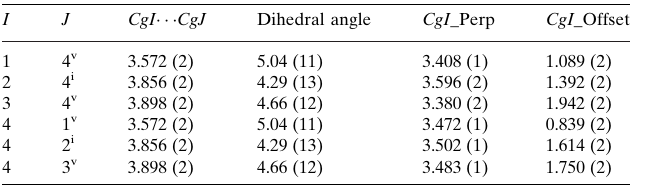
Table 3 (cid:3) – (cid:3) interactions (A˚ , (cid:4) ). Cg 1, Cg 2, Cg 3 and Cg 4 are the centroids of the C9/N10/C11–C14, C1–C4/C11/ C12, C5–C8/C13/C14 and C18–C23 rings, respectively. CgI (cid:2)(cid:2)(cid:2) CgJ is the distance between ring centroids. The dihedral angle is that between the planes of the rings I and J . CgI _Perp is the perpendicular distance of CgI from ring J . CgI _Offset is the distance between CgI and perpendicular projection of CgJ on ring I